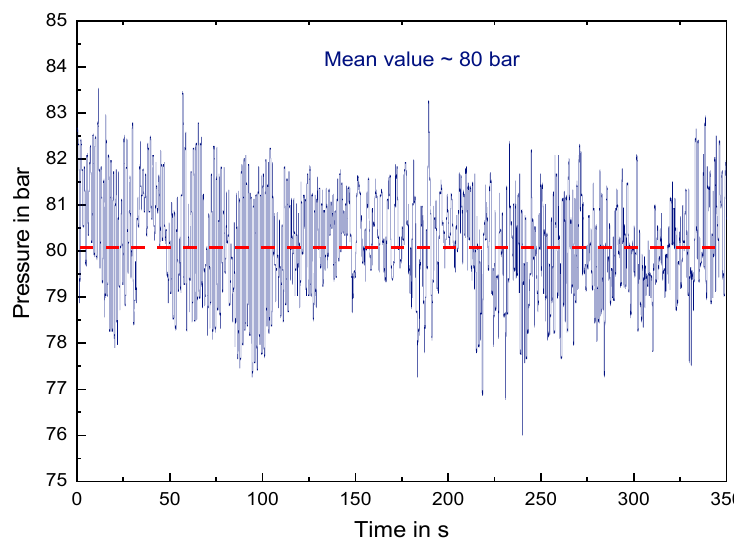
Figure 3. Oscillating pressure profile of the designed back pressure element.